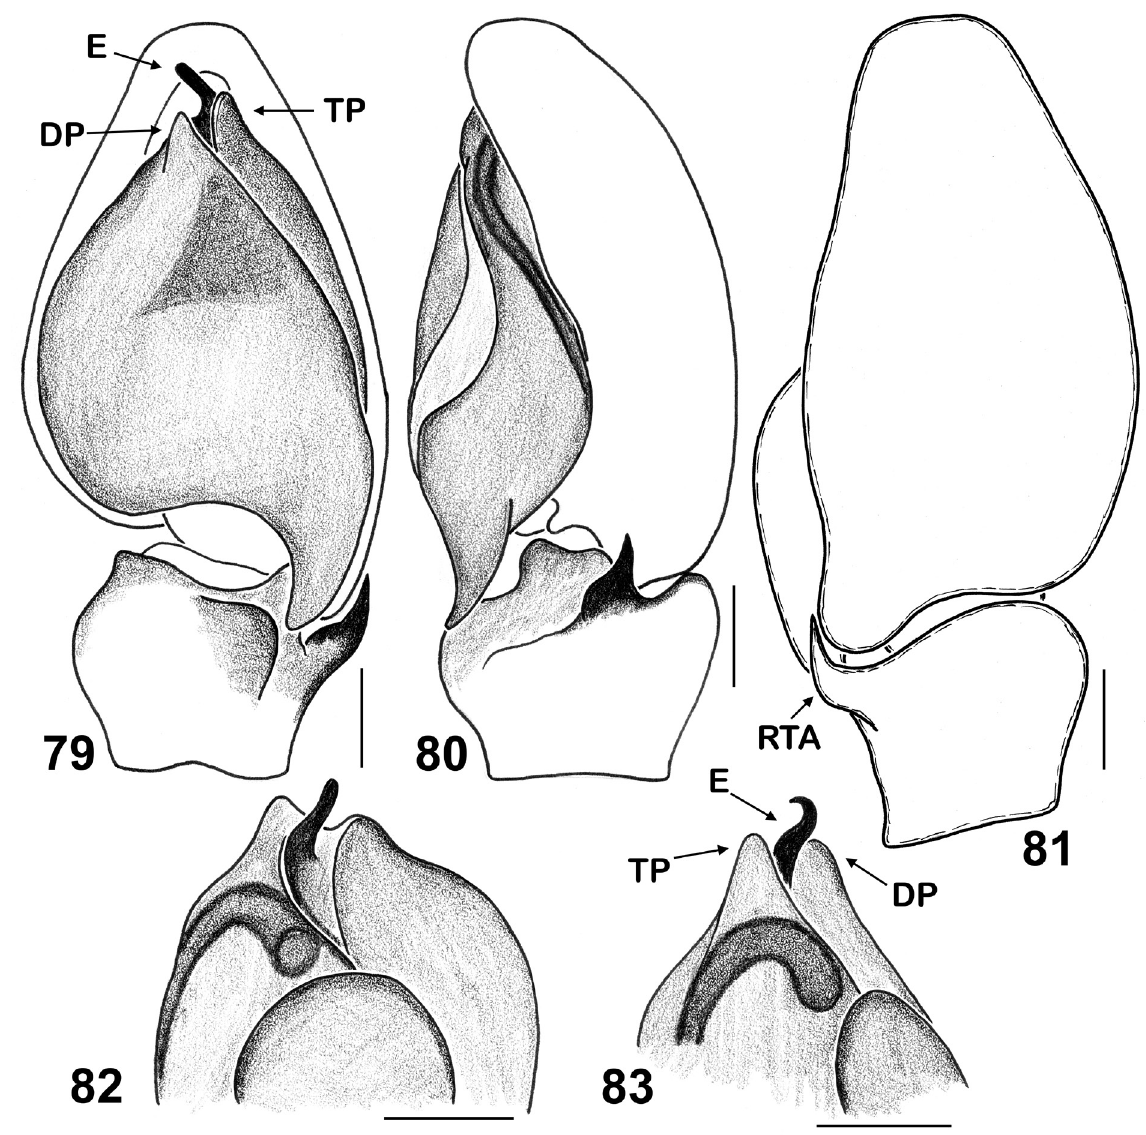
Figs 79–83. Male palp of Stenaelurillus belihuloya sp. nov., holotype. 79 . Ventral view. 80 . Retrolateral view. 81 . Dorsal view. 82 . Embolic division, dorsal view. 83 . Embolic division, retrolateral view. Abbreviations: see Material and methods. Scale bars: 0.1